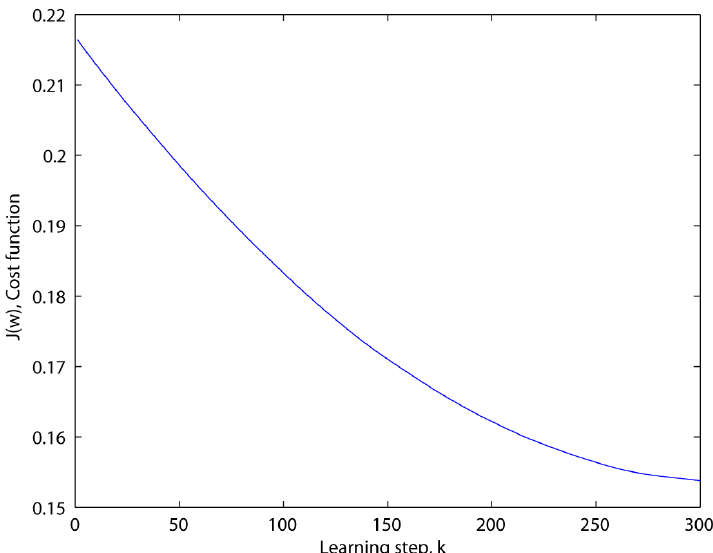
Figure 9. Cost function according to the learning step ( u = 1.0 e –7, ε = 1.0 e –6, β = 10, H =